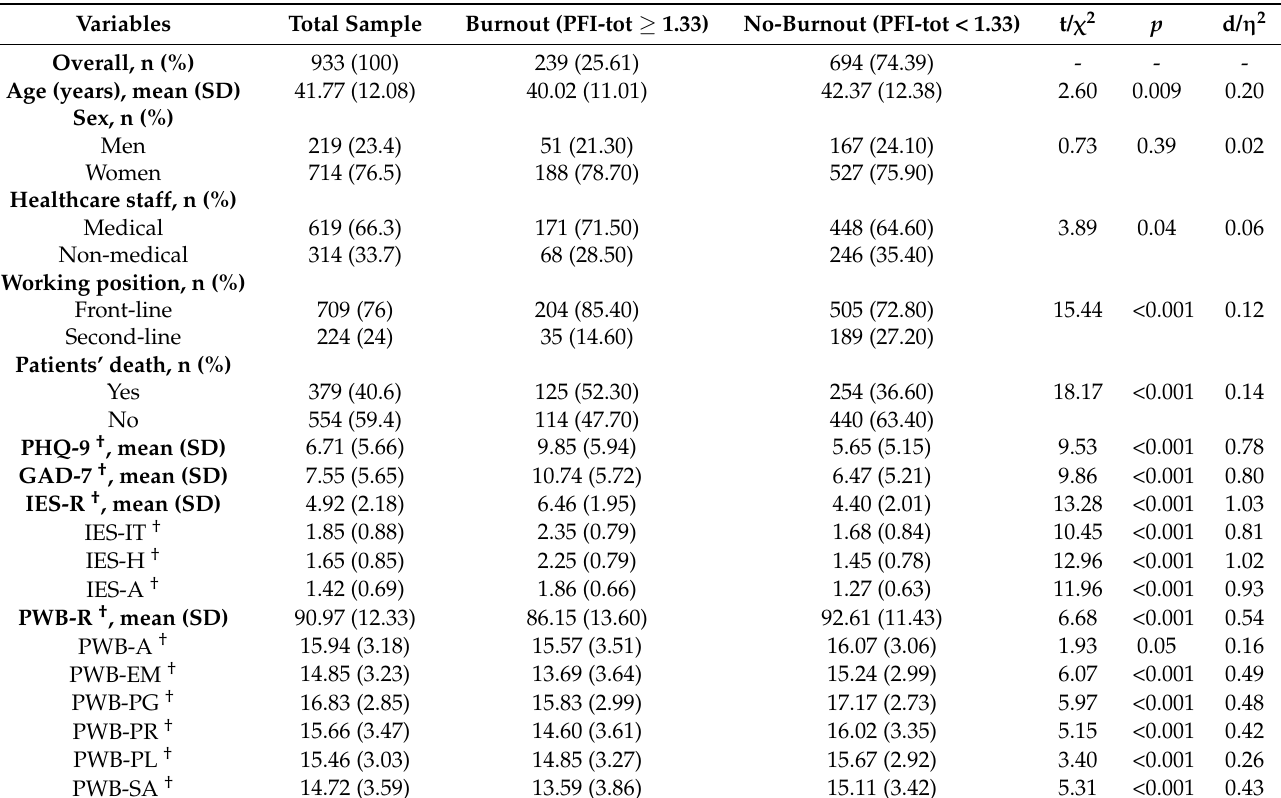
Table 2. Psychological symptoms, sociodemographic and occupational characteristics in the total sample and burnout